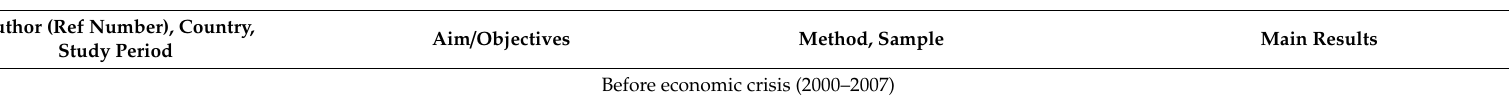
Table 4. Main features and results of the six qualitative studies included in the scoping review about occupational health and safety of immigrant workers in Italy and Spain